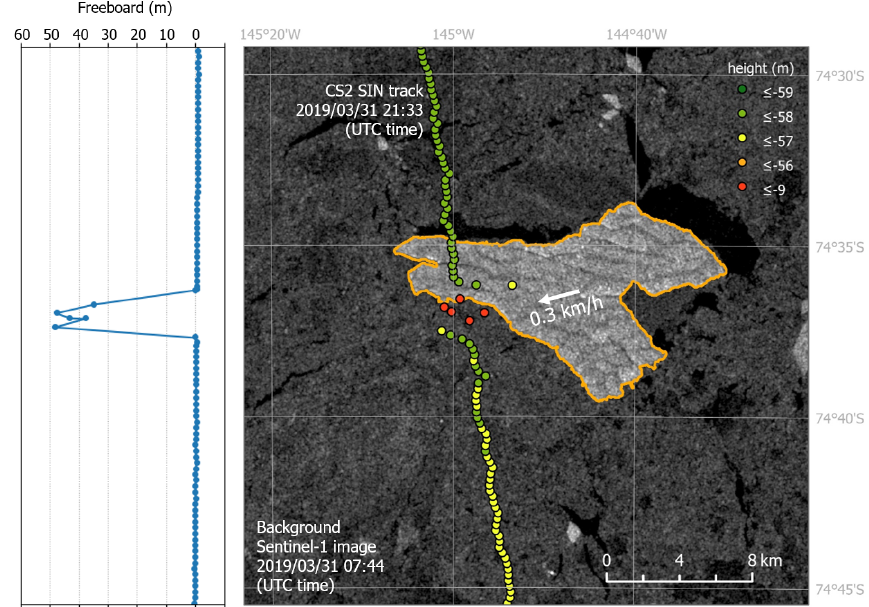
Figure 9. Freeboard measures from the CS2 SIN track on 31 March 2019, and Sentinel-1 image 14h before. Considering the drift of the iceberg between the image and the CS2 SIN track, the highest points (red dots) are the intercepted points on the iceberg by the CS2 SIN track.